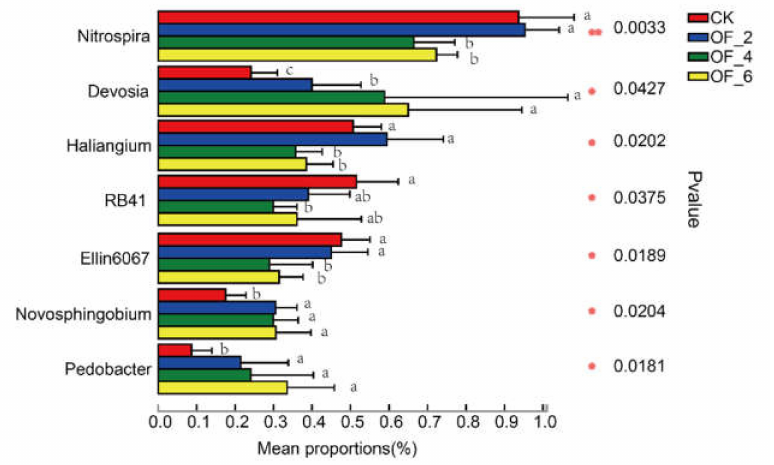
Figure 6. Bacteria with significant differences between different treated soil at the three-leaf stage (genus